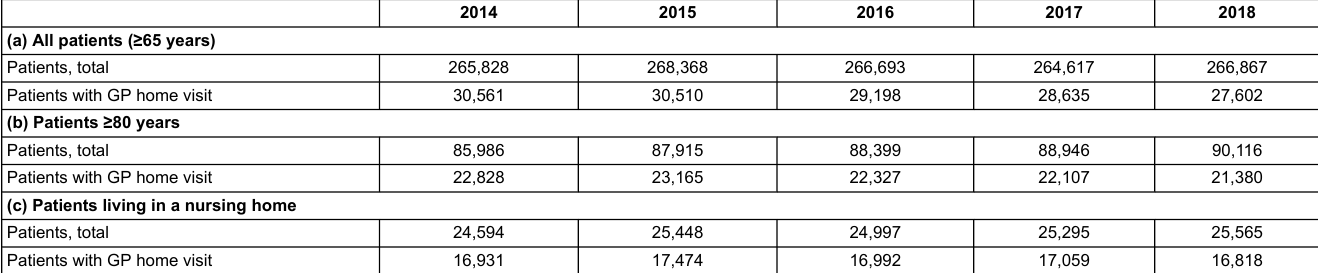
Table S5: The total numbers of patients per year and the number of patients with at least one GP home visit per year, in the Helsana sample for (a) overall patients (aged ≥65 years); (b) subgroup of patients ≥80 years; (c) subgroup of patients living in a nursing home in the same year A significant decrease in GP home visit rates was been observed in all patient groups (p <0.0001, controlled for age and